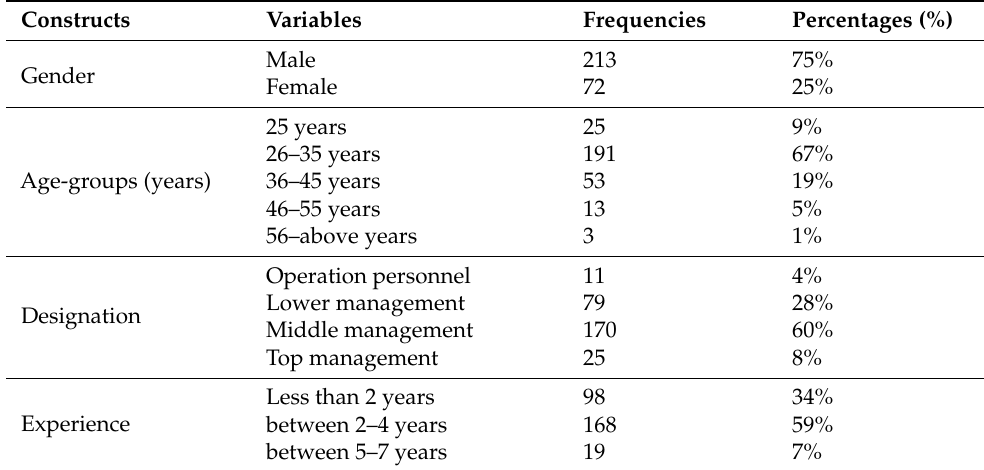
Table 1. Descriptive analysis of demographic variables.